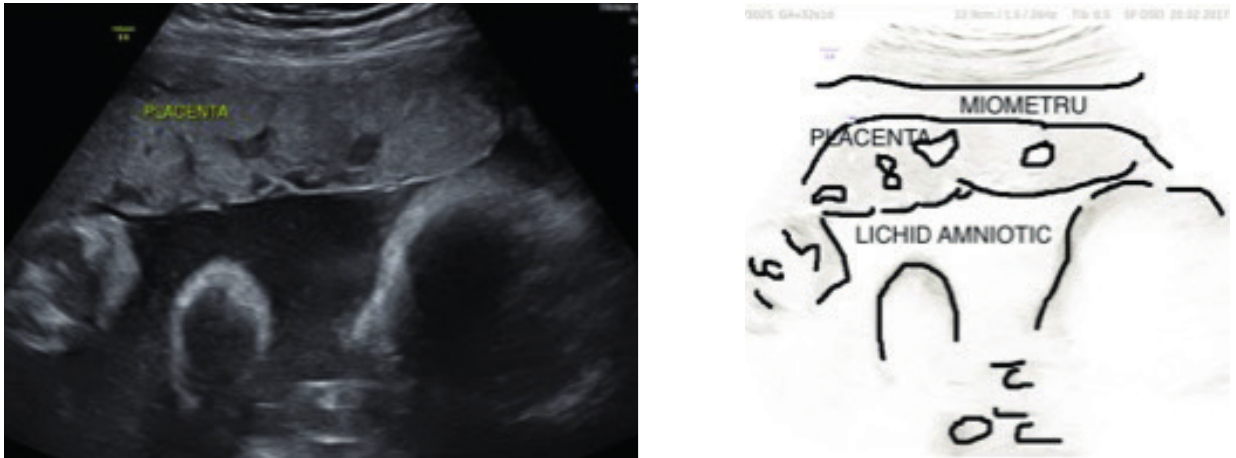
Figure 3 - Anterior placenta in the third trimester of pregnancy: hyperechoic placenta is surrounded by the hypoechoic myometrium, some calsifications and vascular lacs are